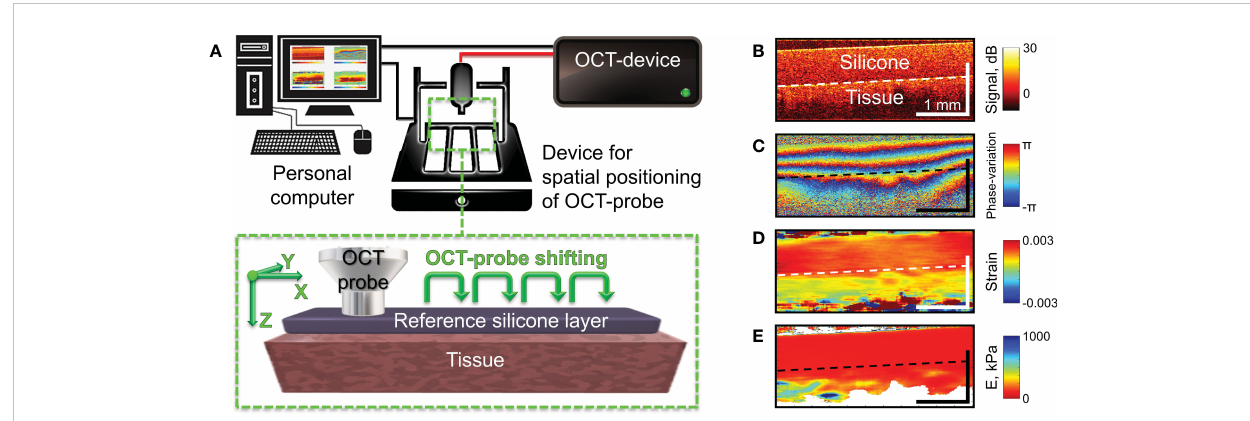
FIGURE 2 Schematic of C-OCE examination and the main stages of C-OCE processing. (A) – OCT scanner with the positioning device to enable acquisition of several maps of the Young ’ s modulus for subsequent stitching in the lateral direction. The reference layer of translucent silicone placed onto the tissue is used for stiffness quanti fi cation. (B) – a typical structural OCT scan for the sandwich structure “ silicone-tissue ” . (C) – a typical map of interframe phase variation obtained during compression of the tissue through the overlying silicone layer. (D) – spatial distribution of interframe strains reconstructed from the phase-variation map shown in panel (C, E) – resultant map of tangent Young ’ s modulus reconstructed from spatially- resolved stress-strain dependences obtained using a series of several tens OCT scans acquired during compression of the tissue for a fi xed lateral position of the OCT-probe. The Young ’ s modulus for every lateral coordinate was estimated for the applied stress of 4 kPa which was controlled by the value of strain in the overlaying reference silicone as described in